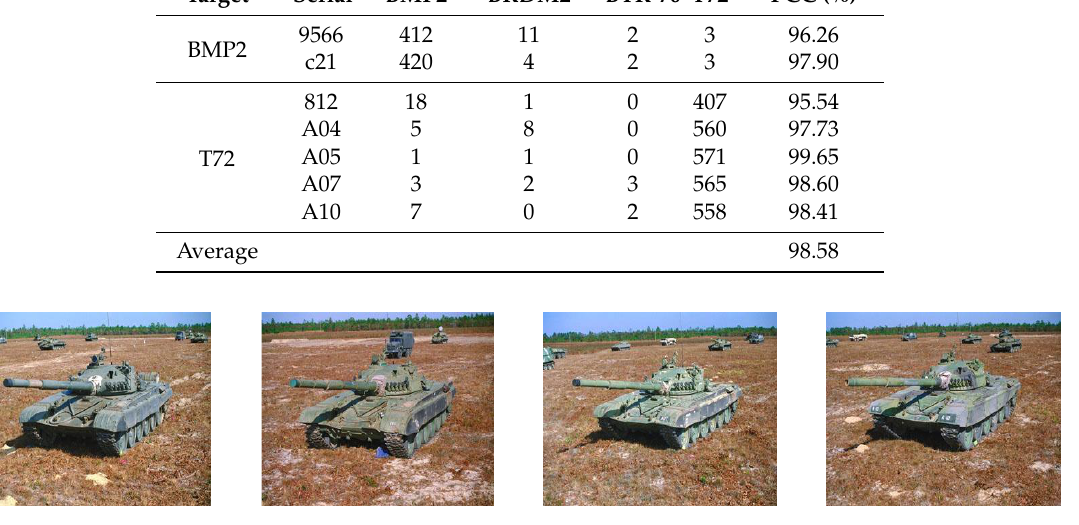
Figure 9. Four different configurations of T72 tank. Table 7. PCCs of all the methods under configuration variants.